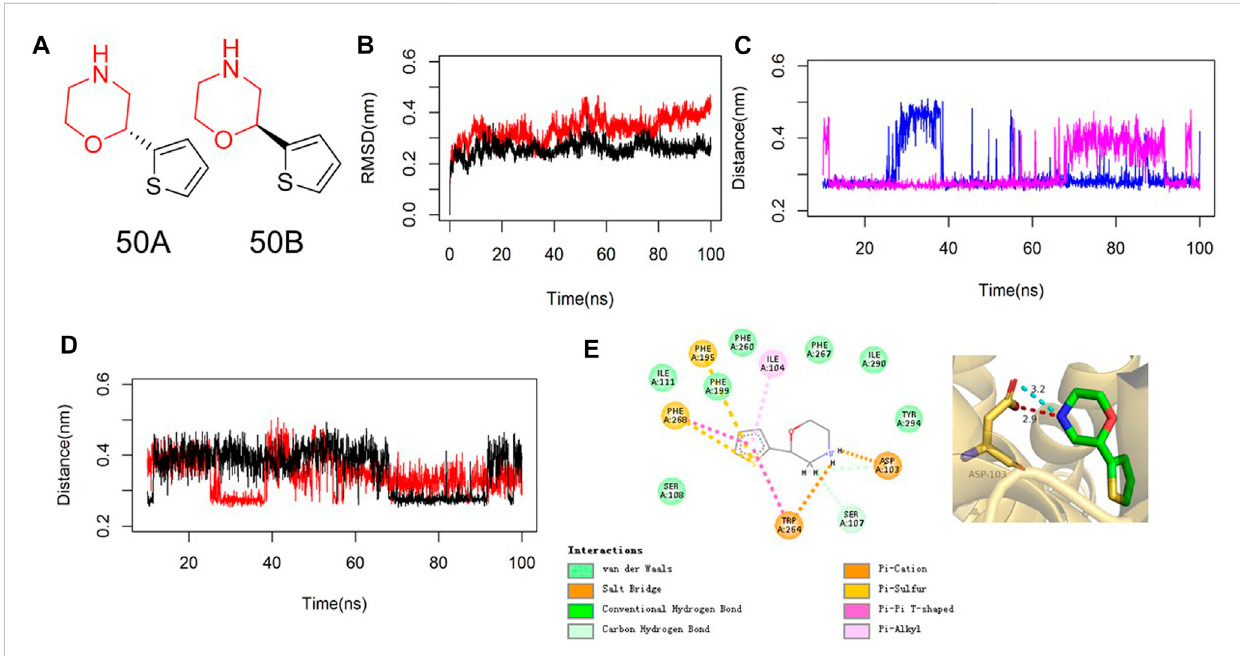
FIGURE 1 MD analyses of 50B bound to TAAR1. (A) Chemical structure of 50A and 50B. (B) RMSD values of 50B (red) or 50A (black) bound to TAAR1. RMSD values are calculated from the backbone after the least squares fi t to thebackbone. (C) Salt-bridge distance of the N atom of morpholine in 50B (blue) or 50A (magenta) with Asp103 in TAAR1. (D) H-bond distance of – NH of 50B (red) or 50A (black) with the side-chain carbonyl O of Asp103 in TAAR1. (E) 2D (left)and3D(right)plotsoftherepresentativeconformationof50BbindingwithTAAR1.ThekeyresiduesinTAAR1and50Bareshowningoldenand green sticks, respectively. The hydrogen bond and electrostatic interaction are shown in red and cyan dashed lines,